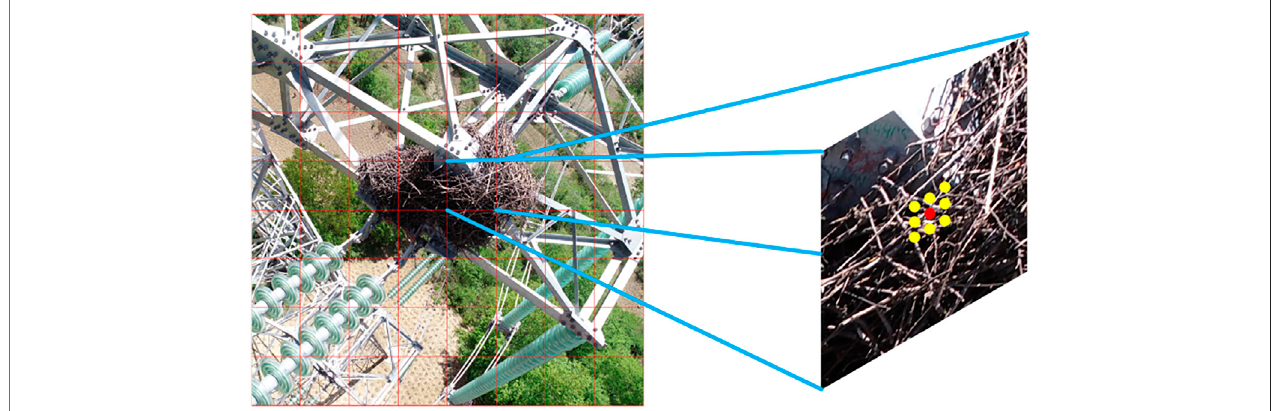
FIGURE 6 | Positive sample candidate area.